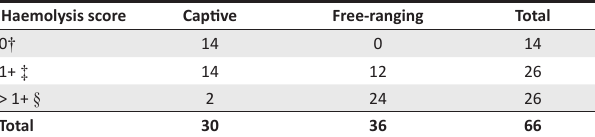
TABLE 2: Comparison of haemolysis scores of serum samples between captive and free-ranging Namibian cheetahs. Haemolysis score